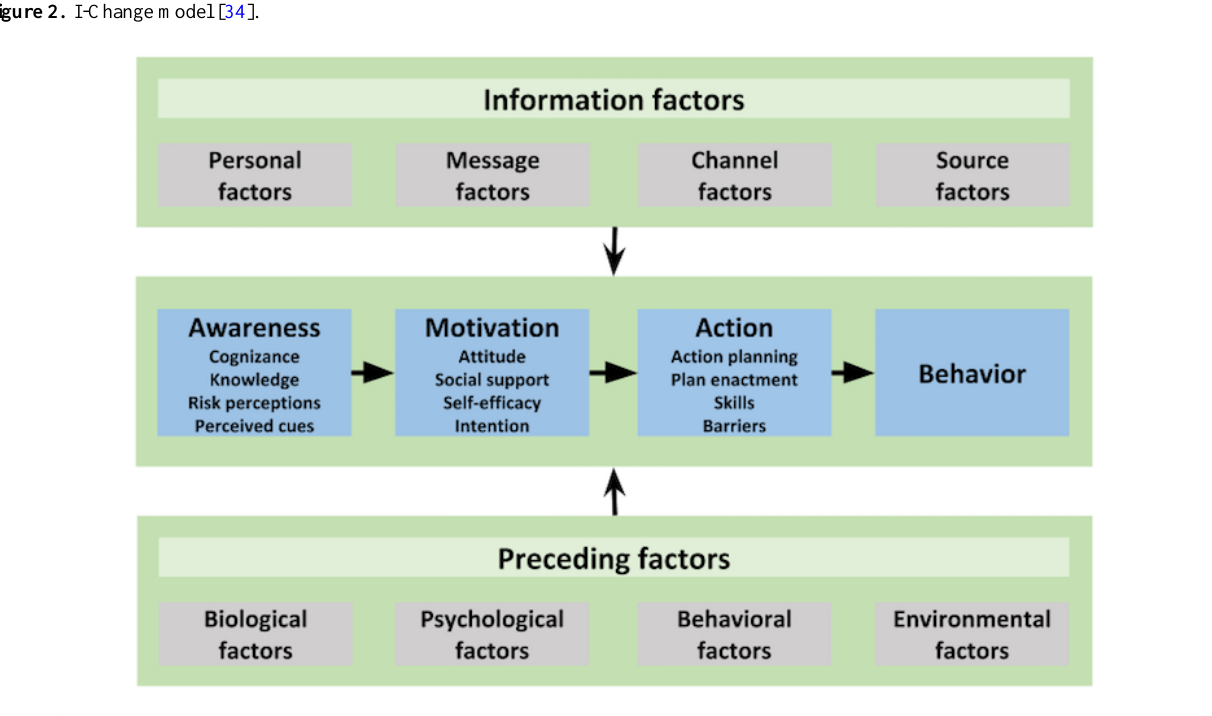
Figure 2. I-Change model [34].